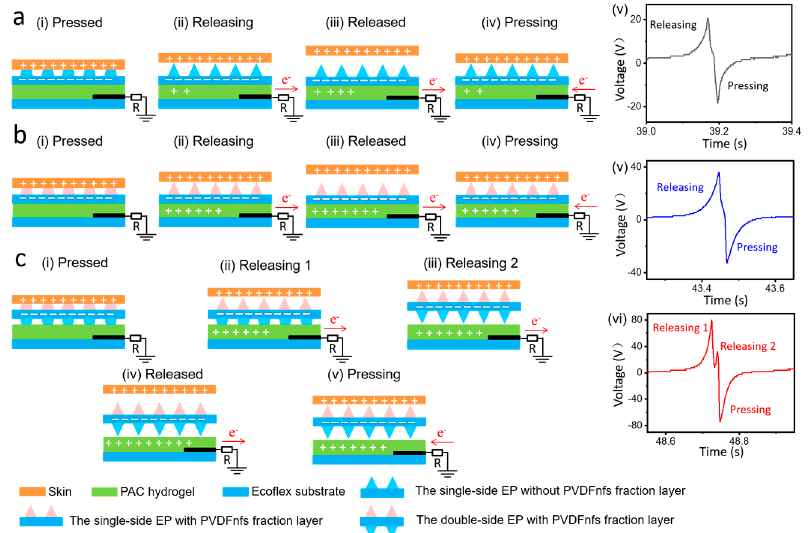
Figure 5. Sketches and the corresponding electrical output voltage curves that illustrate the operating principle of the sensors. ( a ) The single-side EPS with PVDFnfs, ( b ) the single-side EPS with PVDFnfs, and ( c ) the double-side EPS with PVDFnfs.